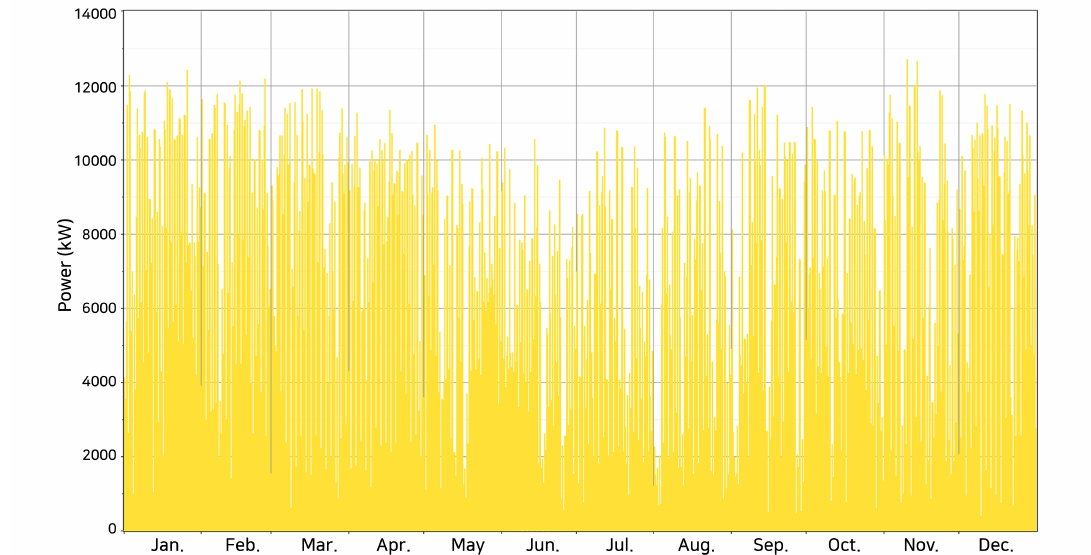
Figure 7. Monthly production of electricity from the suggested configuration (created by the authors).